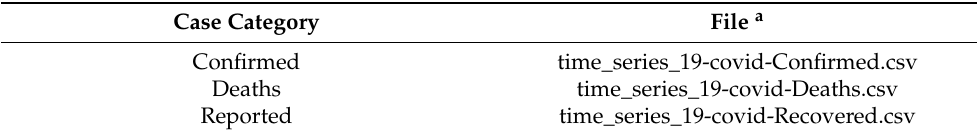
Table 1. Source data